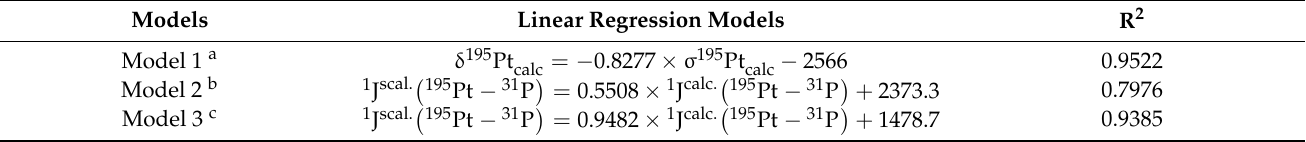
Figure 1. Linear regression between: ( a ) calculated σ 195 Pt and experimental δ 195 Pt for a set of 30 Pt(0) complexes (Model 1); ( b ) calculated and experimental 1 J( 195 Pt– 31 P) for a set of 33 coupling constants in 26 linear and trigonal-planar Pt(0) complexes (Model 2); and ( c ) calculated and experimental 1 J( 195 Pt– 31 P) for a set of 29 coupling constants in 22 trigonal-planar Pt(0) complexes (Model 3). Table 1. Empirical scaling models obtained to predict δ 195 Pt and 1 J( 195 Pt– 31 P) in Pt(0) complexes.